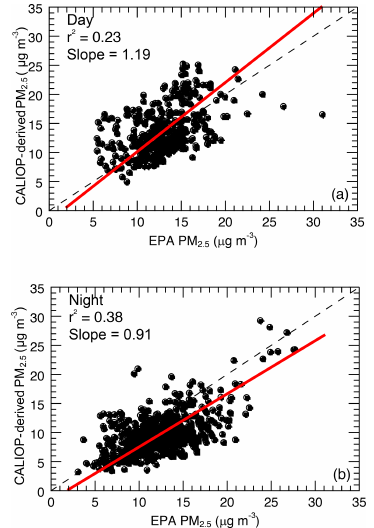
Figure 9. For 2008–2009, scatter plots of mean PM 2 . 5 concentra- tion from ground-based U.S. EPA stations and those derived from collocated all-sky (including cloud-free and cloudy profiles) near- surface CALIOP observations, using (a) daytime and (b) nighttime CALIOP data. The red lines represent the Deming regression